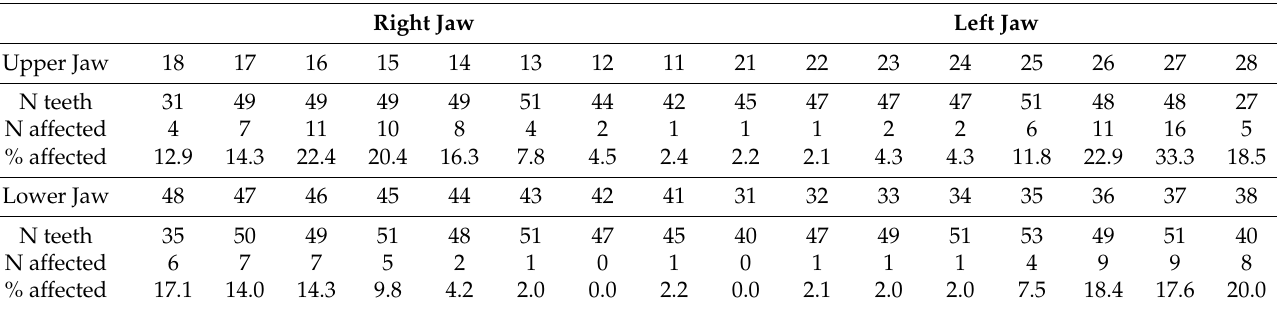
Table 5. Distribution of carious lesions in the dentition of adult individuals from all sites with information on the number of assessable (N teeth) and carious teeth (N affected). The teeth were named according to the FDI